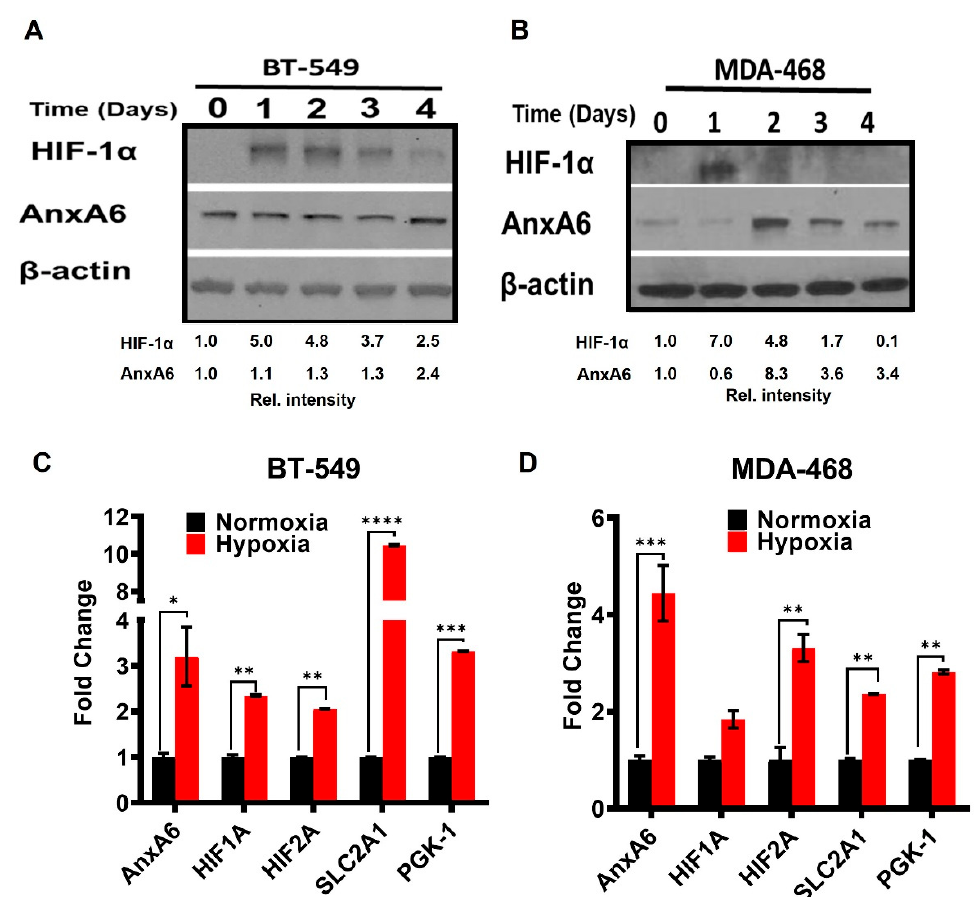
Figure 1. Differential Response of TNBC cells to hypoxic conditions. ( A , B ) Representative TNBC cell models depicting AnxA6-high mesenchymal-like (BT-549) and AnxA6-low basal-like (MDA-468) TNBC cell lines were incubated under hypoxic conditions (37 ◦ C; 1% O 2 ; 5% CO 2 ; 94% N 2 ) for the indicated times. Whole cell lysates were prepared and assessed by Western blotting using antibodies against the indicated proteins. Detection of β -actin was used as a loading control. ( C , D ) TNBC cells were cultured under hypoxic conditions for 96 h and the expression of AnxA6 , HIF-1/2A , and its downstream target genes SLCA21 - and PGK-1 genes were assessed by RT-PCR. Statistical significance was calculated using the Mann–Whitney U- test in GraphPad. In parts C , D , each bar represents the mean ± SEM of duplicate analysis from three independent experiments. Asterisks (* p ≤ 0.05; ** p ≤ 0.01; *** p ≤ 0.001; **** p ≤ 0.0001) compared to normoxic values.